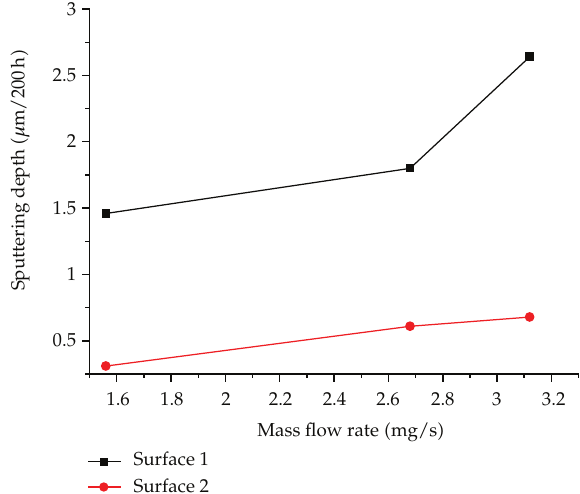
Figure 11: Max sputtering depth on